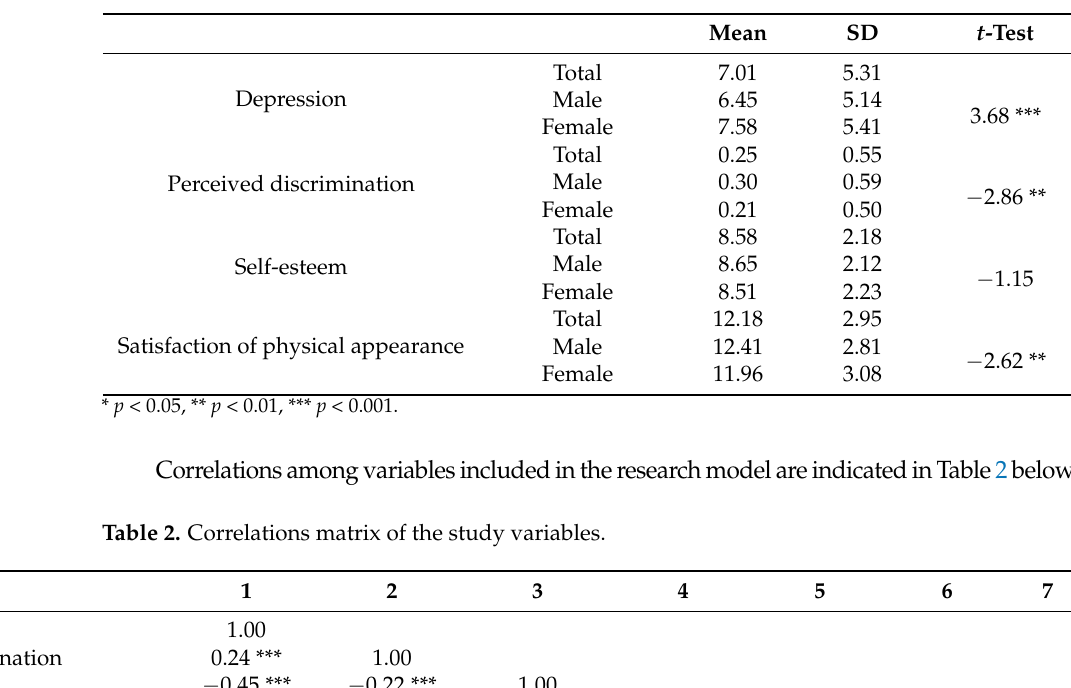
Table 1. Descriptive statistics of the key variables.